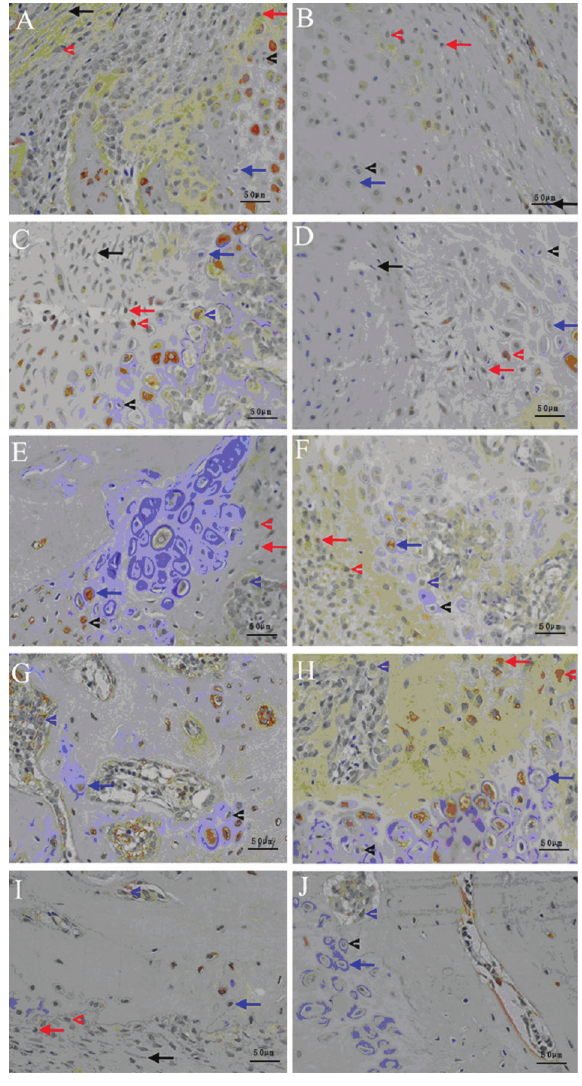
Figure 4. Local expression of bone morphogenetic protein-2 (BMP-2) during fracture healing is shown in the control ( A ) and diabetes ( B ) groups after 1 week of healing, 2 weeks of healing ( C ) and ( D ), 3 weeks of healing ( E ) and ( F ), 4 weeks of healing ( G ) and ( H ), and 5 weeks of healing ( I ) and ( J ), respectively (DAB (cid:1) 200). Red arrows: osteogenic cells; red arrowheads: osteo- blasts in the subperiosteal bone; black arrows: fi broblast-like cells; black arrowheads: proliferating chondrocytes; blue arrows: mature chondrocytes; blue arrowheads: osteoblasts in the trabecular bone near to endochondral ossi fi cation front.